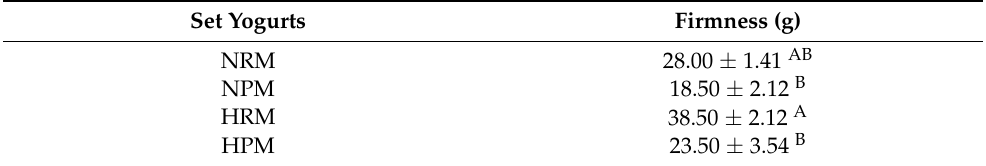
Table 2. Firmness of set yogurt produced with an enriched